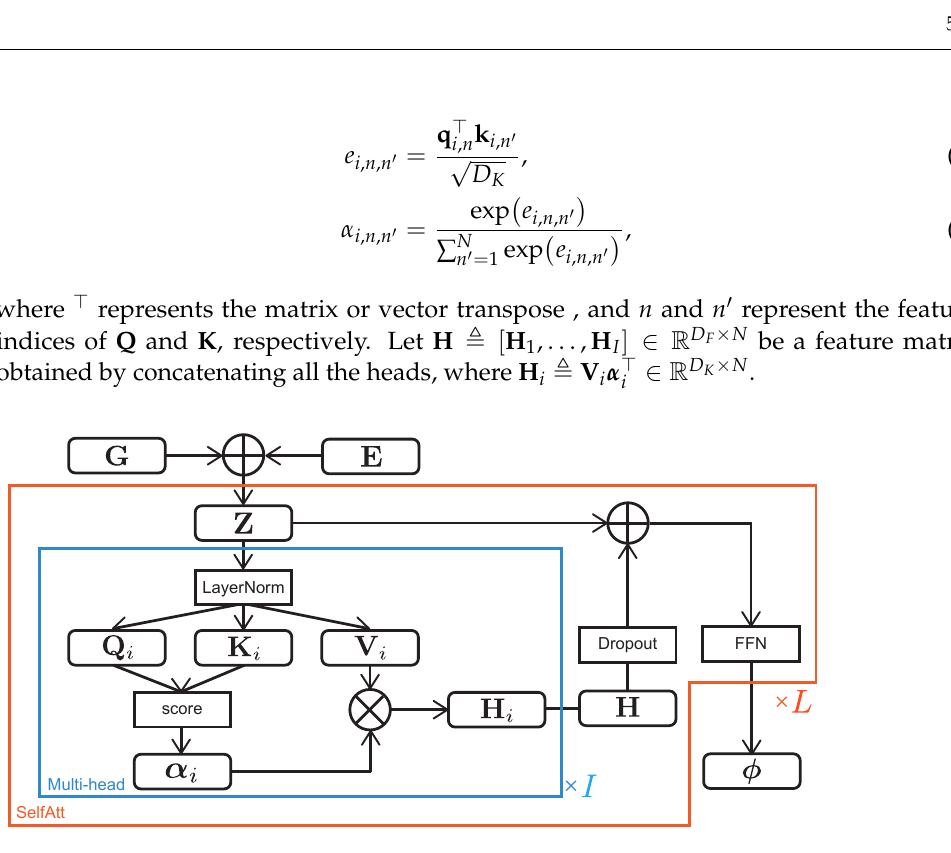
Figure 3. The proposed transcription model with a multi-head self-attention